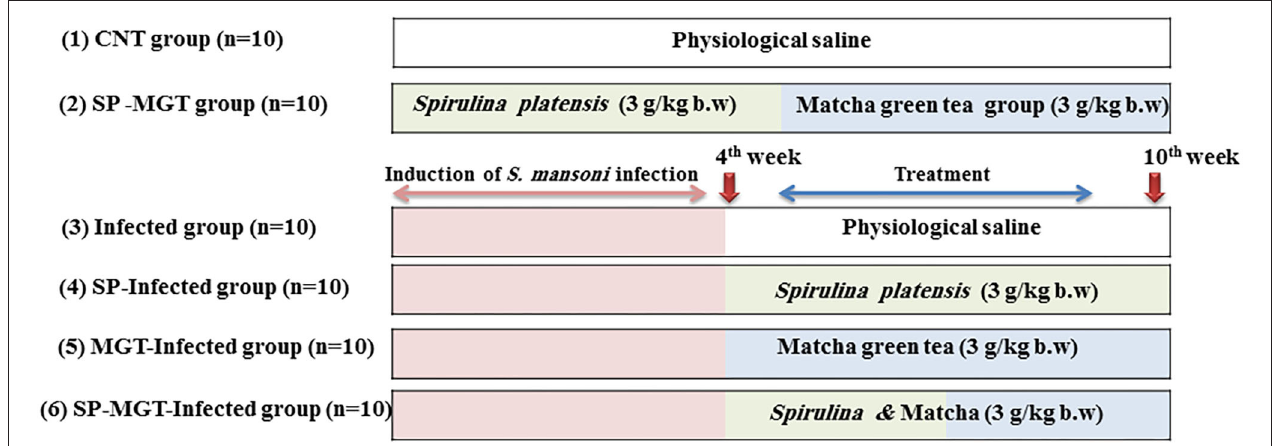
FIGURE 1 | Time scheme, treatment protocol, and doses of used SP and MGT.